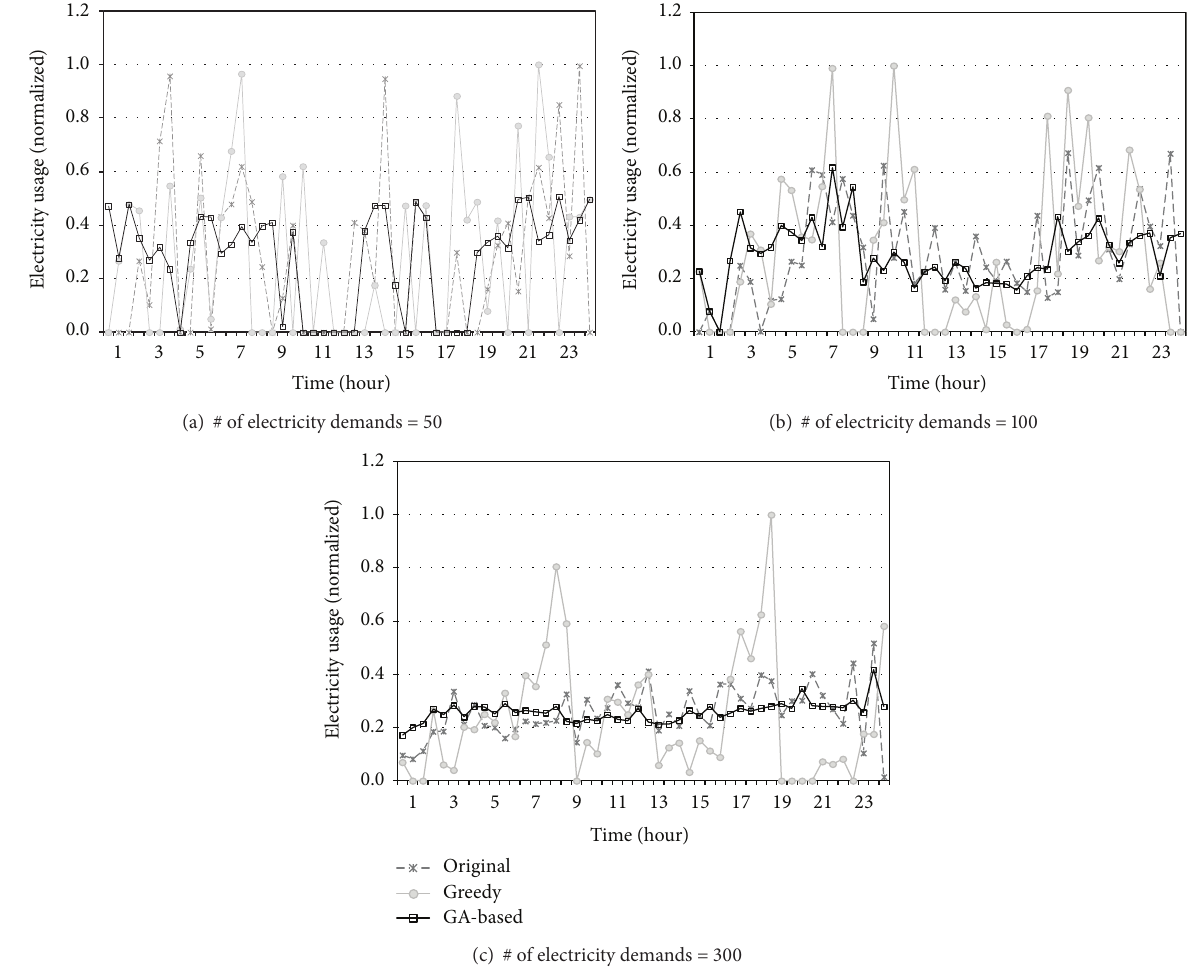
Figure 12: Electricity usage of each time slot of a